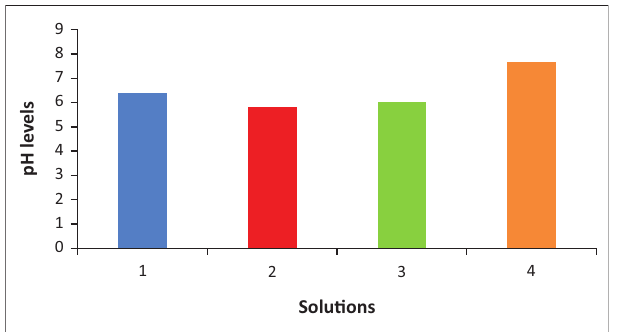
FIGURE 3: The pH levels of the different solutions before and after synthesis of silver nanoparticles (AgNPs): (a) methanol, (b) silver nitrate, (c) leaf crude methanol extract and (d) AgNPs.